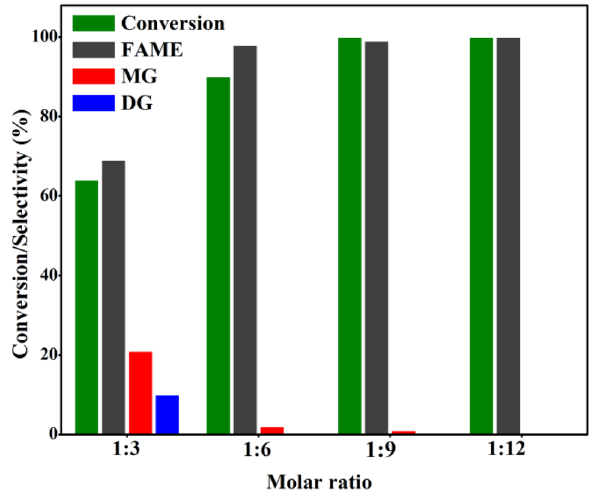
Fig. 12 Effect of MeOH/oil ratio with respect to 20% HPWA/KIT-6 in transesterification of neem oil (reaction conditions: catalyst, 0.35 g; oil, 10 g; 60 °C; run time, 3 h)